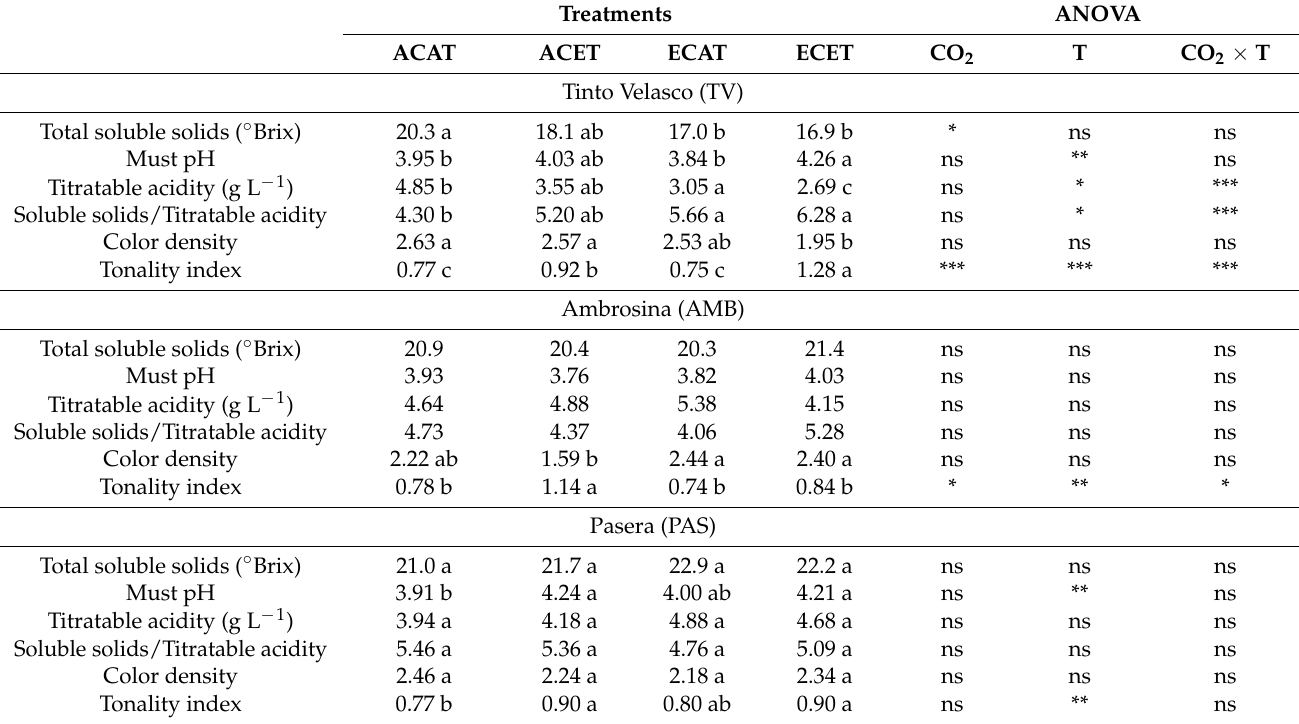
Table 1. Must characteristics in three Spanish autochthonous grapevine varieties cultivated at (1) ambient (~400 µ mol mol − 1 ) CO 2 concentration (AC) and ambient temperature (AT) (ACAT); (2) AC and elevated (T + 4 ◦ C, ET) temperature (ACET); (3) elevated CO 2 (700 µ mol mol − 1 , EC) and AT (ECAT), and (4) EC and ET (ECET). Values are means (n = 3–6). Within each parameter and grapevine variety, values followed by same letter or with absence of letters do not differ significantly ( p ≥ 0.05). Significance of analysis of variance (ANOVA): *** p ≤ 0.001; ** p ≤ 0.01; * p ≤ 0.05; ns, not significant ( p ≥ 0.05). T = temperature